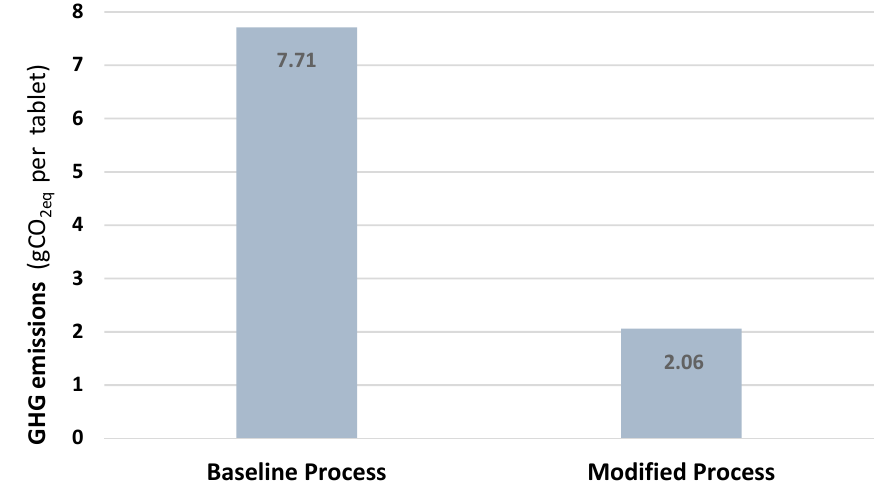
Figure 4. GHG emissions comparison in old process and new process for one tablet produced.